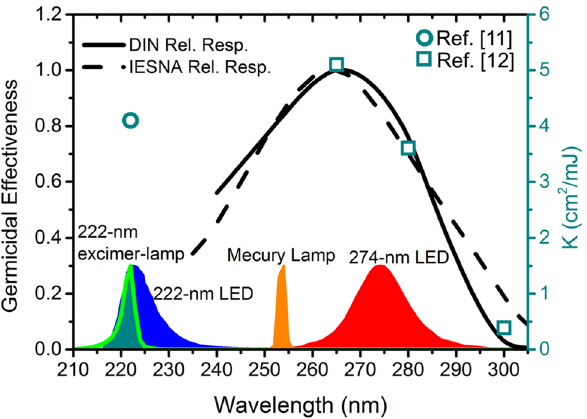
Figure 4. The germicidal effectiveness provided by Deutsches Institut für Normung (DIN) 23 and Illuminating Engineering Society of North America (IESNA) 24 , and SARS-CoV-2 inactivation coefficient K versus radiation wavelength in which the scatter points achieved from the experiments 11 , 12 . The typical spectra of excimer lamp (luminous green line), UV-C LEDs (blue for 222-nm and red for 274-nm), and mercury lamp (orange) are shown at the bottom of the